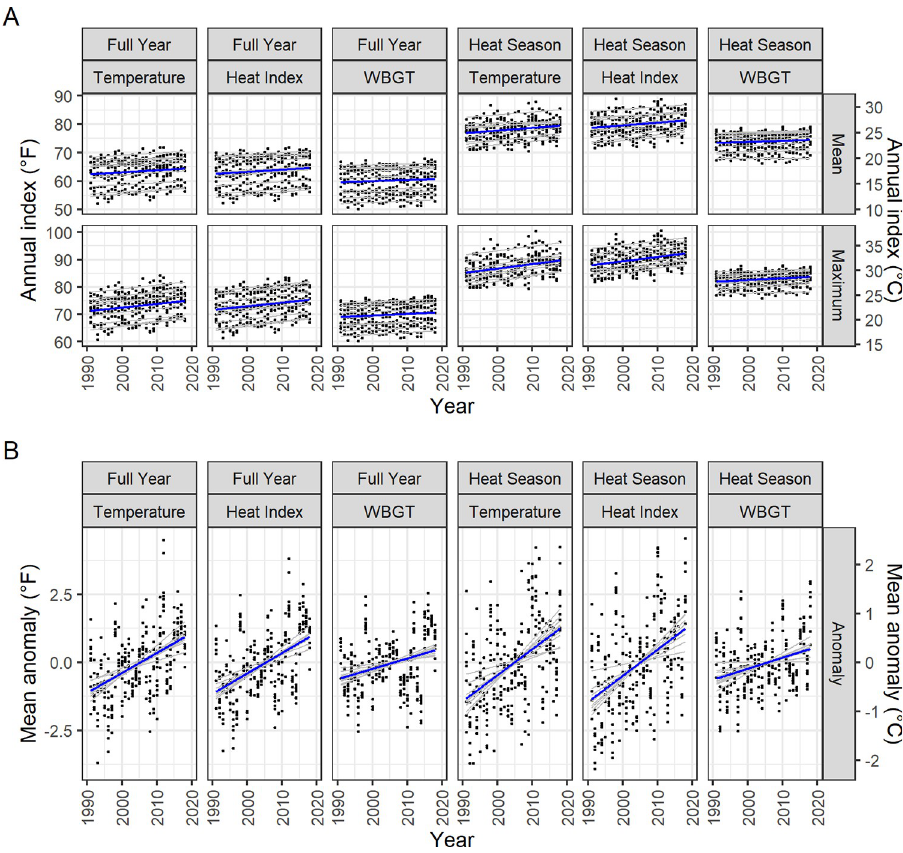
Fig 3. Annual trends of full-year and heat season degree-based indices of heat at 10 CONUS U.S. Army installations, 1991–2018. Panel A displays annual means of mean and maximum daily index values. Panel B displays annual means of daily anomalies, relative to location-based 1990–2019 climatologies. Thick blue lines depict the linear trend through all data points. Thin gray lines depict location-specific trends. Indices are in˚F on the left y-axis and in ˚C on the right